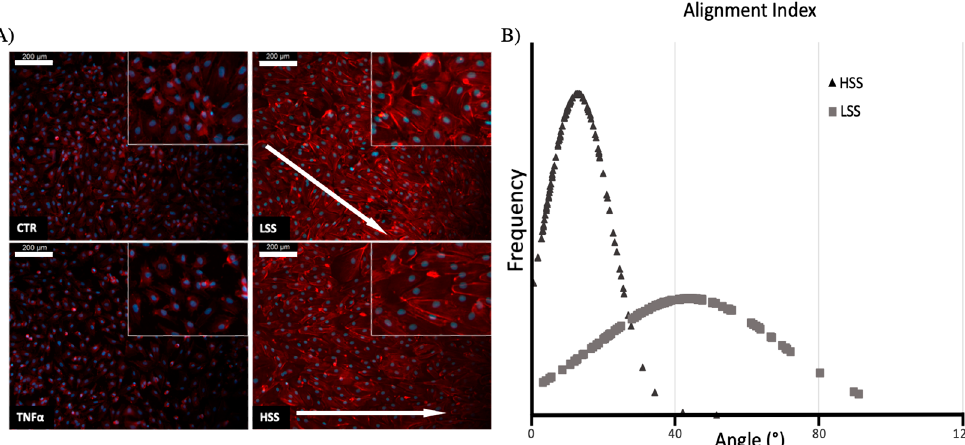
Figure 1. ( A ) F-actin fluorescence analysis on HUVECs cultured in static and dynamic conditions. Nuclei are stained in blue, while actin filaments are stained in red. White arrow indicates the flow direction. ( B ) Quantitative analysis of the angles subtended by the cell’s major axis and the flow direction ( p < 0.001). Scalebar: 200 µ m.